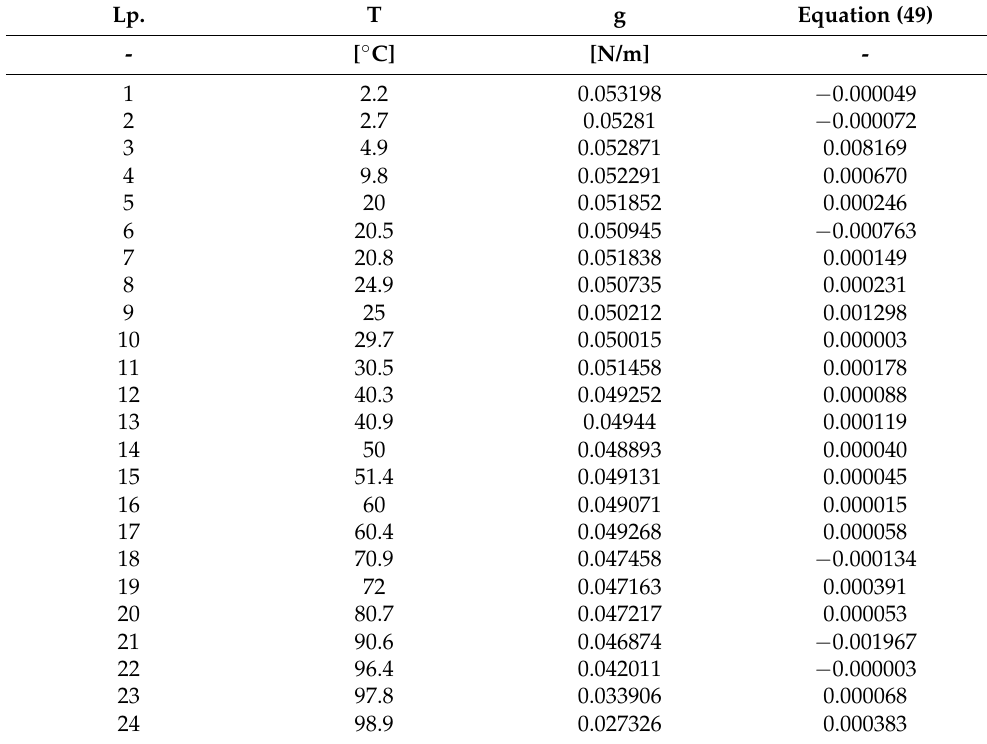
Table 1. The results of the spare equation (49) for the determined interface tensions. Lp.